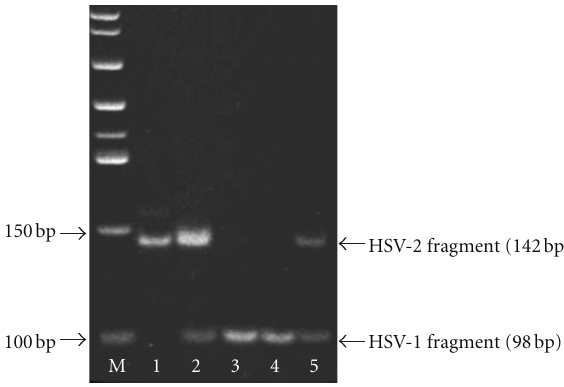
Figure 3: HSV typing via RFLP analysis. Electrophoresis of rep- resentative nested-PCR products, positive for HSV, digested with M sp I. M: 50 bp marker (New England Biolabs), 1: undigested nested-PCR product (142 bp), 2: positive control containing both HSV-1 (98bp) and HSV-2 (142bp) genomic sequences, 3-4: